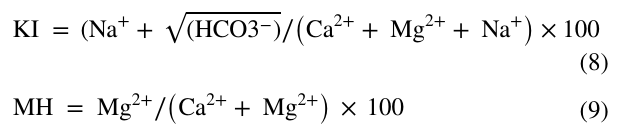
pHParameters Max permissible